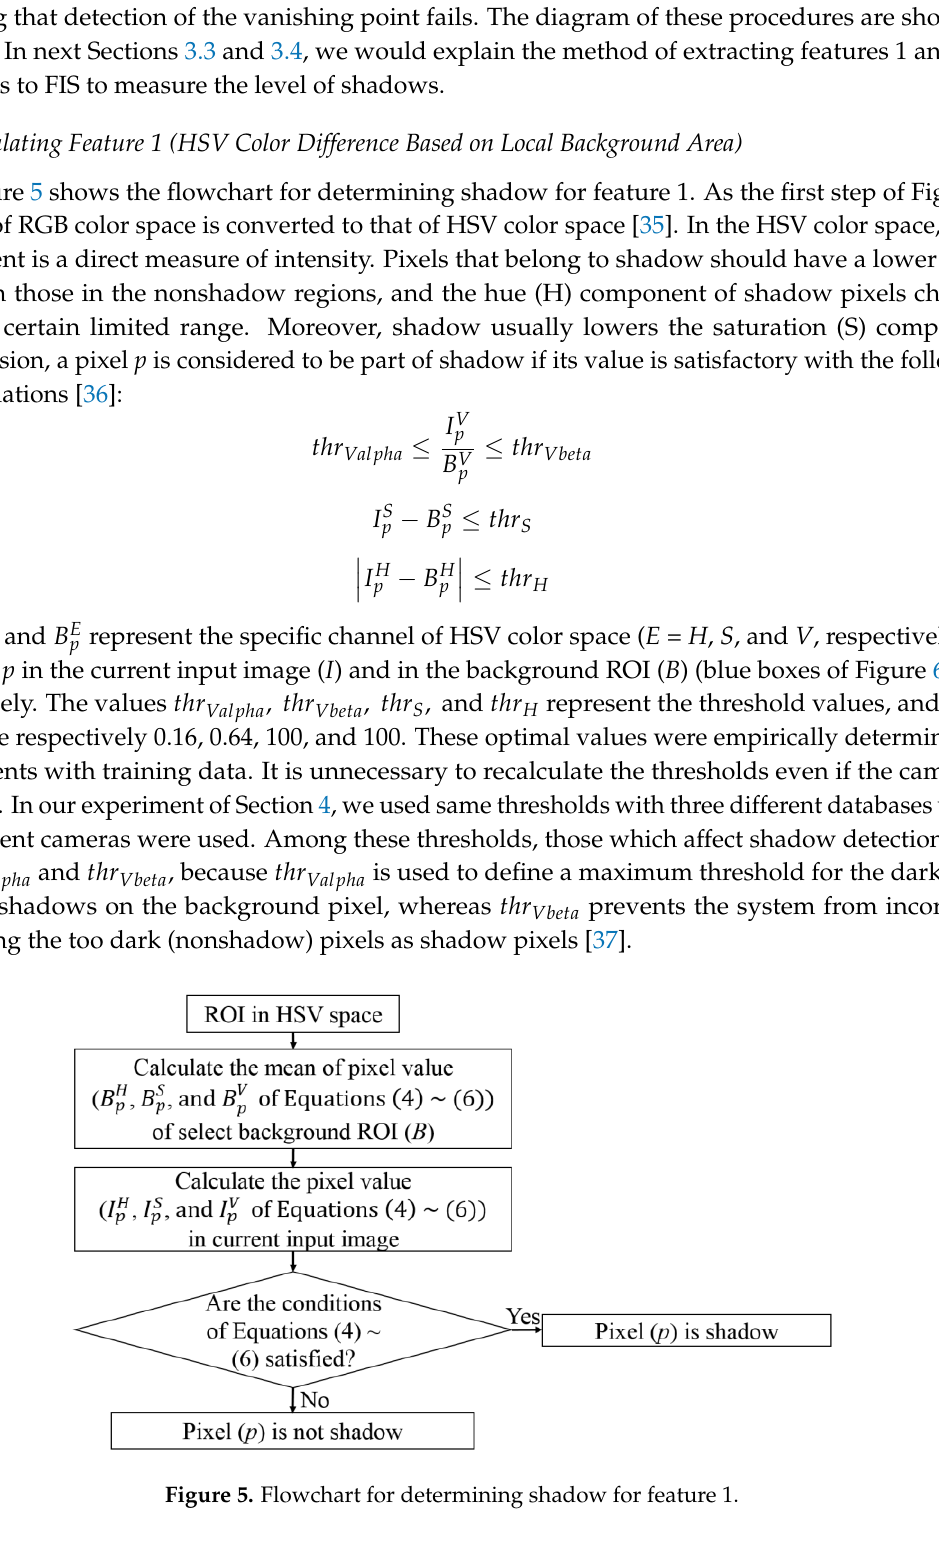
( f ) Figure 6. Examples of extracted shadows for calculating feature 1. Background ROI ( B ) of Equations (4)–(6) and Figure 5 is shown by the blue box in Figures 6a,c,e: ( a , c , e ) Image in the ROI; ( b , d , f ) binarization image of detected shadow by Figure 5.